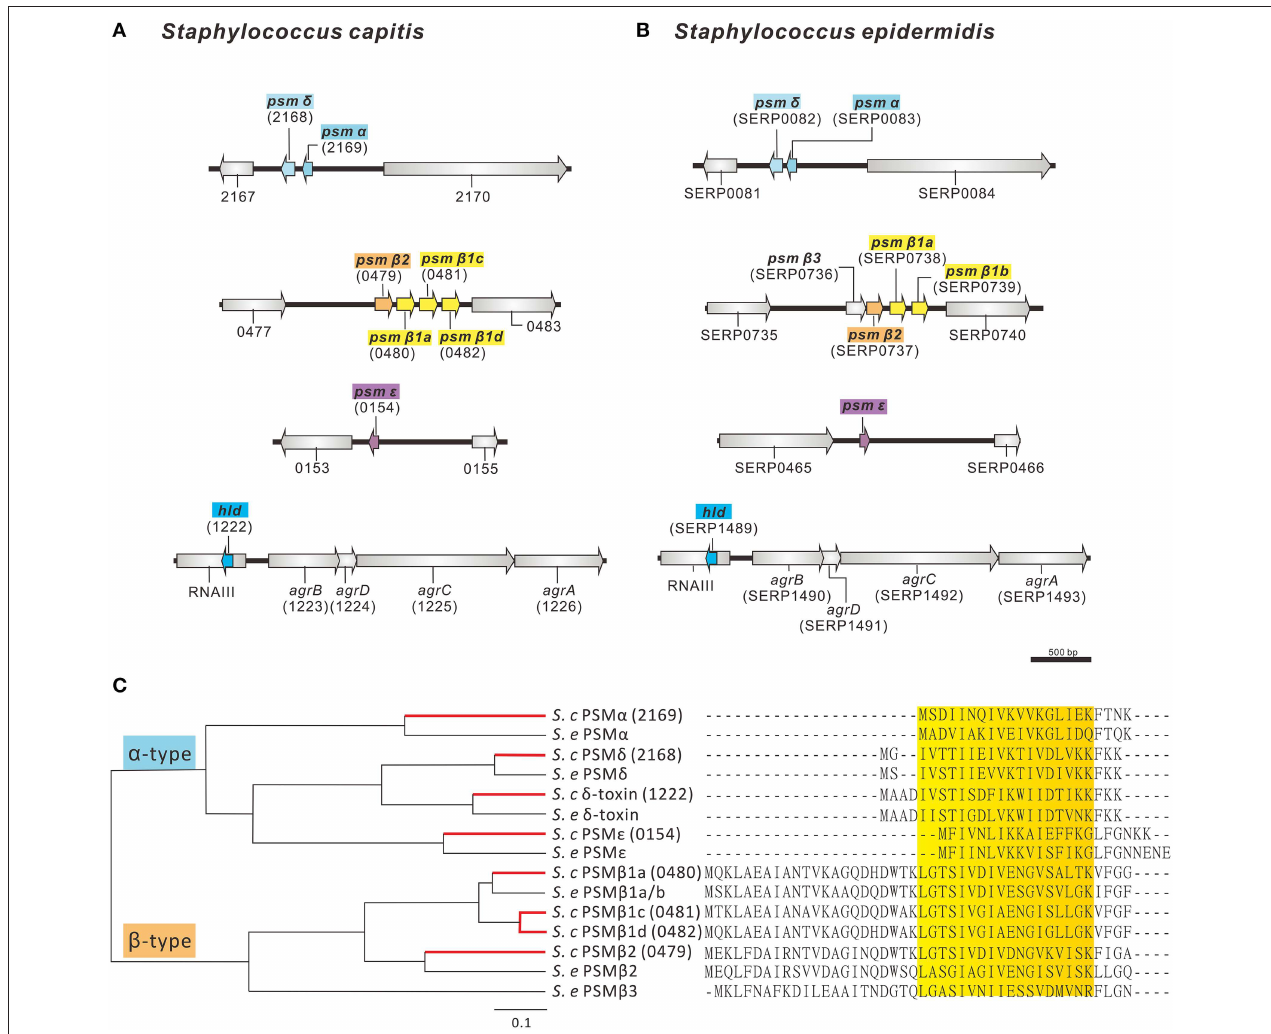
FIGURE 5 | Predicted phenol-soluble modulin (PSM) genes and amino acid sequences in S. capitis AYP1020. The genetic arrangement of phenol soluble modulin genes in AYP1020 (A) is highly similar when compared to S. epidermidis RP62a (B) . In each case, PSMs are found on 4 distinct genetic loci. Predicted PSMs of S. capitis have high amino acid sequence identity when compared to S. epidermidis RP62a (C) . AYP1020 has both α - and β -type PSMs, which are classed based on length. Each PSM contains an amphipathic α -helix, which is highlighted in yellow. AYP1020 has three distinct PSM β 1 genes (a, c, and d), whereas RP62a has two identical copies of PSM β 1 (a and